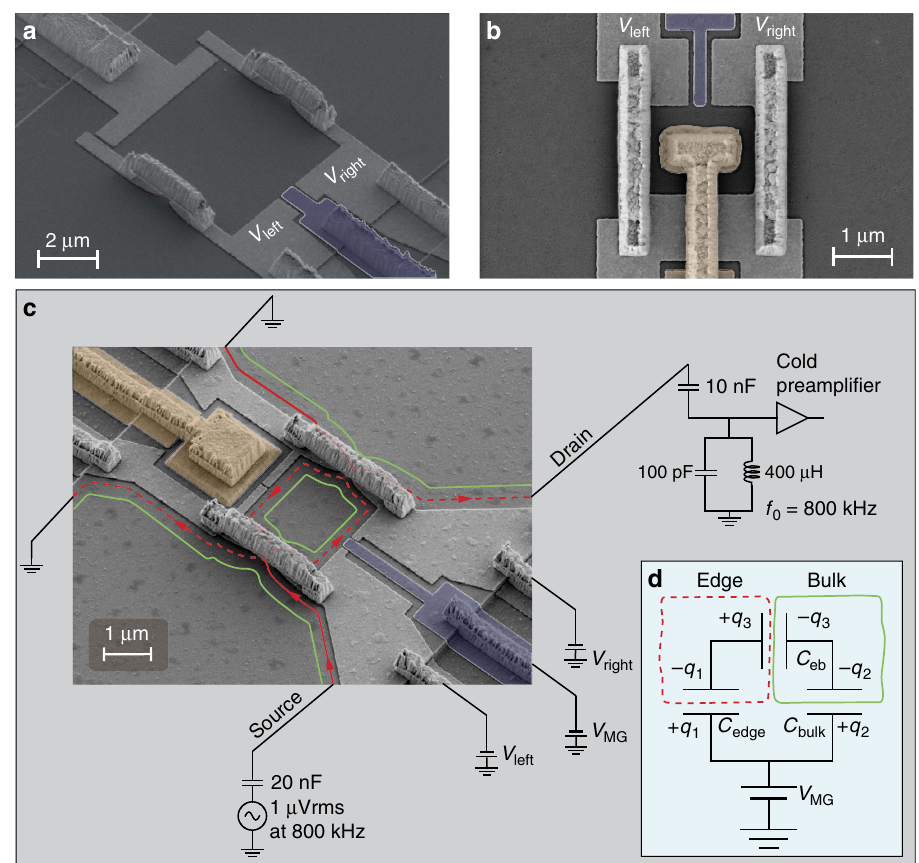
Figure 1 | Scanning electron microscopy images and an illustration of the experimental set-up. ( a ) Bare FPI; such devices show distinct Coulomb dominated (CD) behaviour. ( b ) FPI with a grounded Ohmic contact in its centre (gold, false colour) aimed at screening Coulomb interactions; such devices show Aharonov–Bohm (AB) interference. ( c ) FPI with a grounded Ohmic contact in its close proximity (gold, false colour), inducing partial screening of Coulomb interactions; such devices show intermediate behaviour between the CD and AB. Red lines represent edge states and arrows represent the current’s chirality. Current is injected into the device from the source, partitioned at the two QPCs, and probed at the drain employing a cold amplifier. Partitioned current is denoted by dashed lines. Modulation gates are marked by blue (false colour) in all images. ( d ) An equivalent electric circuit model describing the interferometer system with filling factor 1 o v B o 2. The system consists of the lowest Landau level’s edge (denoted as ‘edge’), the bulk (denoted as ‘bulk’) and the modulation gate. The mutual capacitances between all three, C eb , C edge and C bulk , are marked on top of the circuit. The excess charge on the edge is denoted d Q edge ¼ d q 3 (cid:2) d q 1 , while the excess charge in the bulk is d Q bulk ¼(cid:2) d q 3 (cid:2) d q 2 . Further details on the capacitive model are provided in analysis, as well as in Supplementary Note 2 and